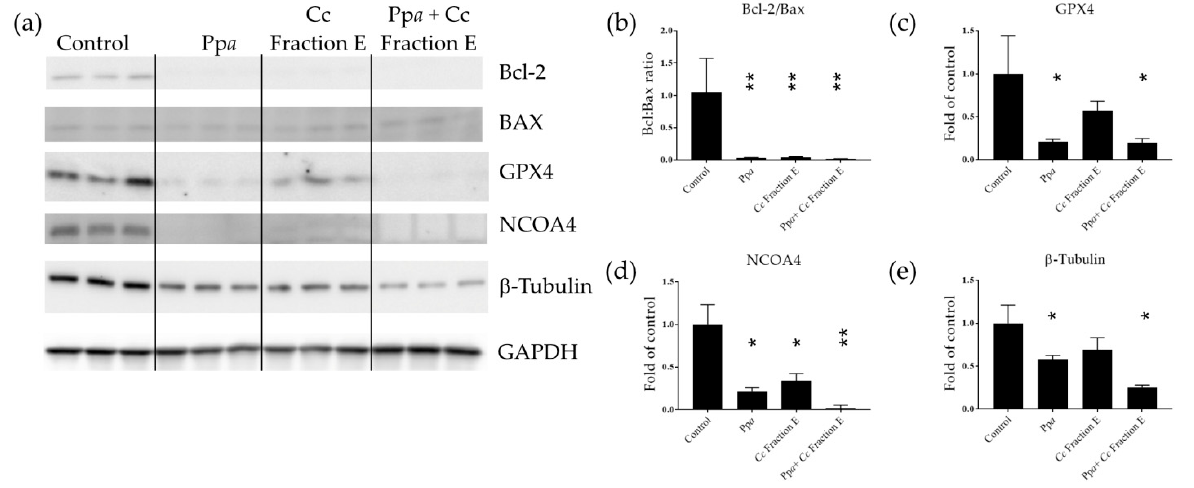
Figure 2. Western blotting analyses. ( a ) Immunodetection of Bcl-2, Bax, GPX4, NCOA4 and beta-tubulin in treated cells with Pp a , Cc fraction E or both, followed by photo-activation; ( b ) Bcl-2/Bax ratio; ( c ) band intensity for GPX4, ( d ) NCOA4, ( e ) β -Tubulin normalized with glyceraldehyde 3-phosphate dehydrogenase (GAPDH) (* p < 0.05; ** p < 0.01).